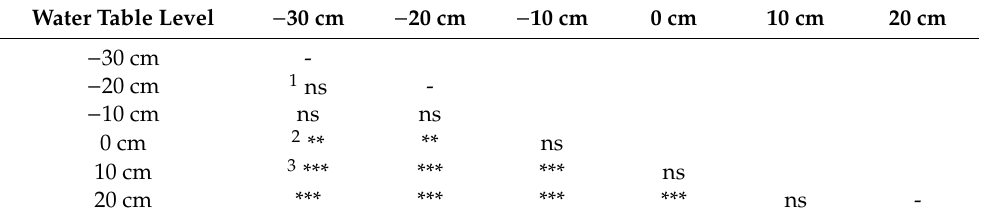
Table 1. Results of the multiple comparison analysis using the Tukey post-hoc test with Bonferroni correction. ** and *** indicate significant di ff erences between two groups.